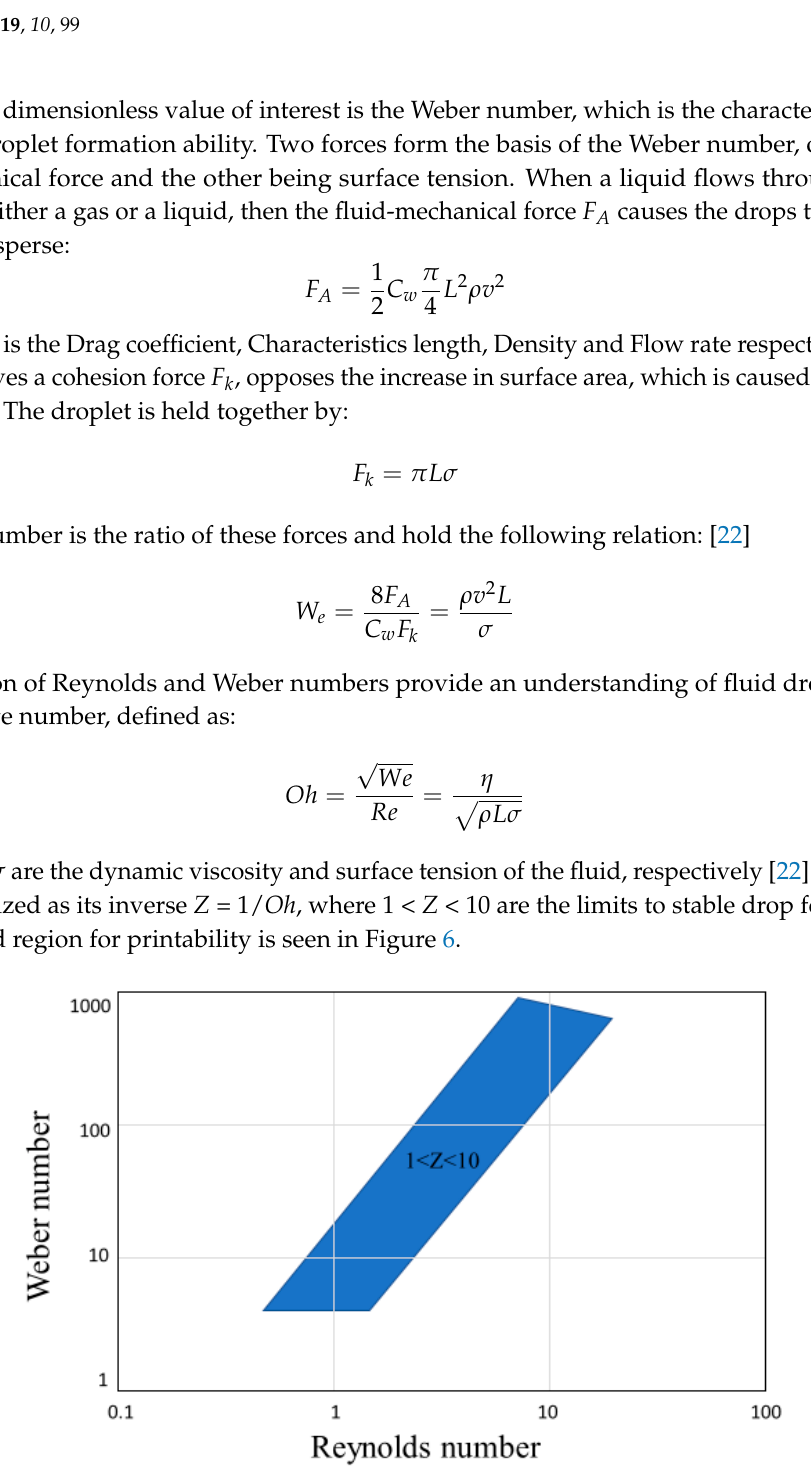
Figure 6. Graphical representation of the idealized region for stable printing, where 1 < Z < 10, the inverse of the Ohnesorge number. The depicted blue area is the Goldilocks zone for 3D printing.